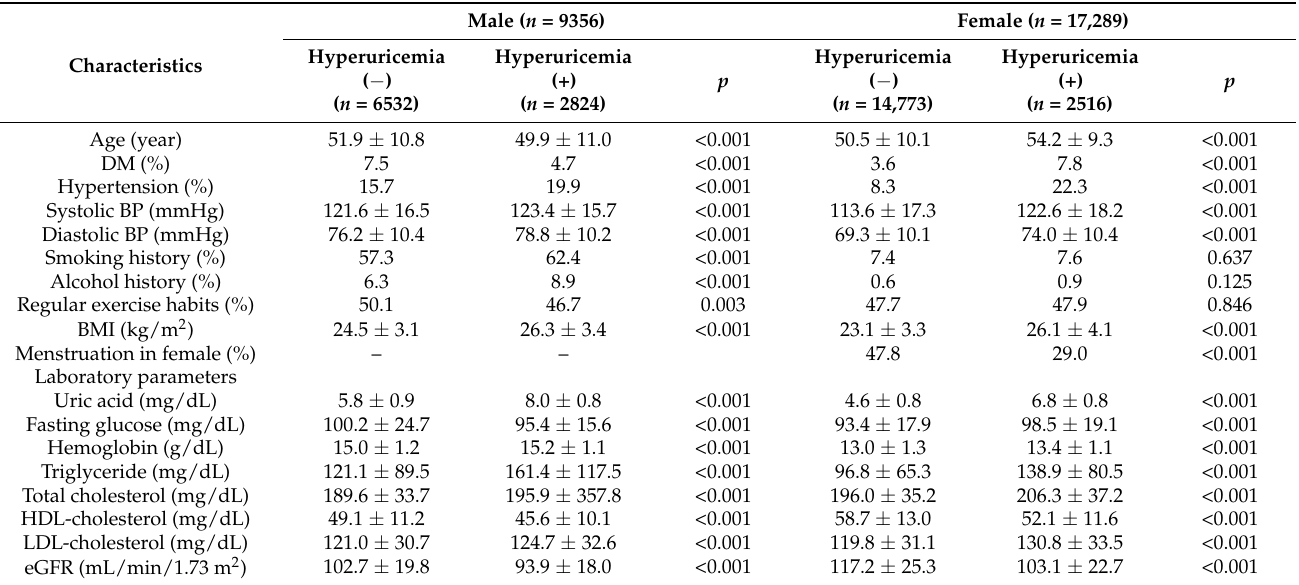
Table 3. Clinical characteristics of the study participants classified by the presence of different sex and